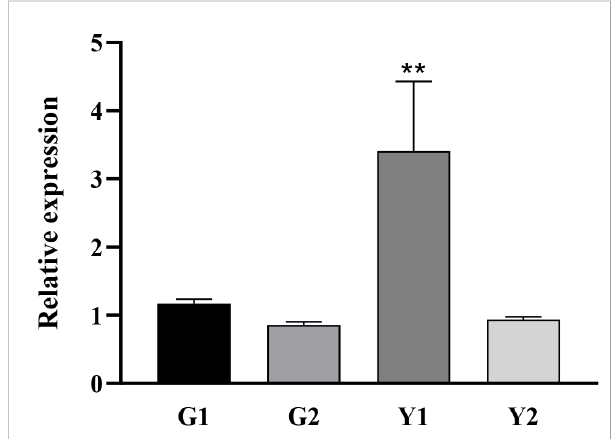
FIGURE 5 Tissue speci fi c expression of CbuDnaJ49 in C. bungei